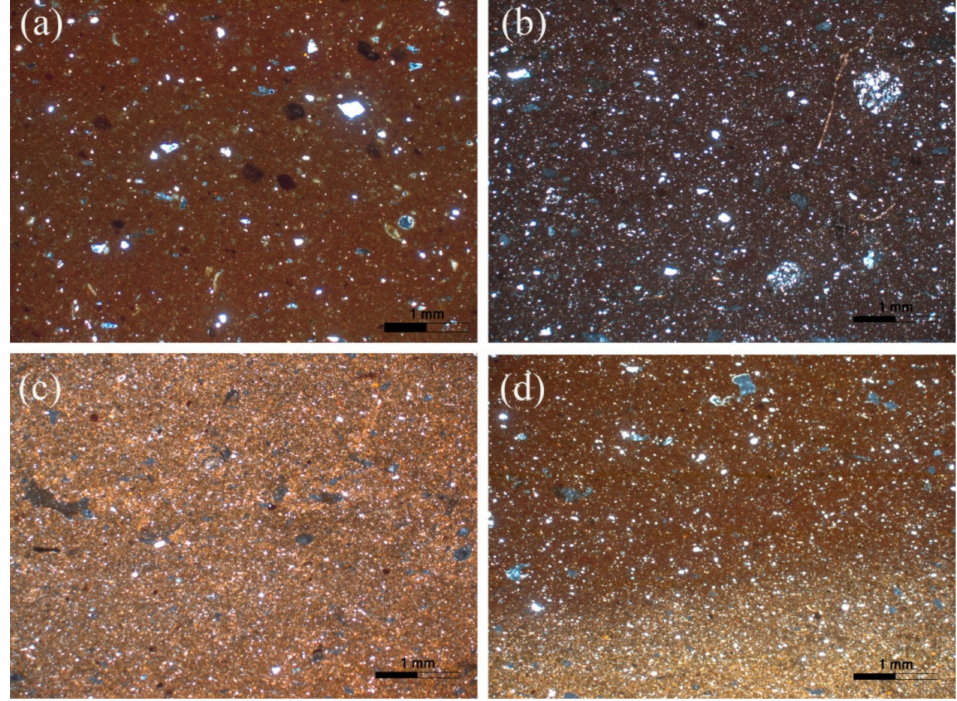
Figure 7. Representative photomicrographs of the fabric group 5. ( a ) Sample K2; ( b ) K12; ( c ) K27 and ( d ) K95. All photomicrographs are taken under crossed Nicols